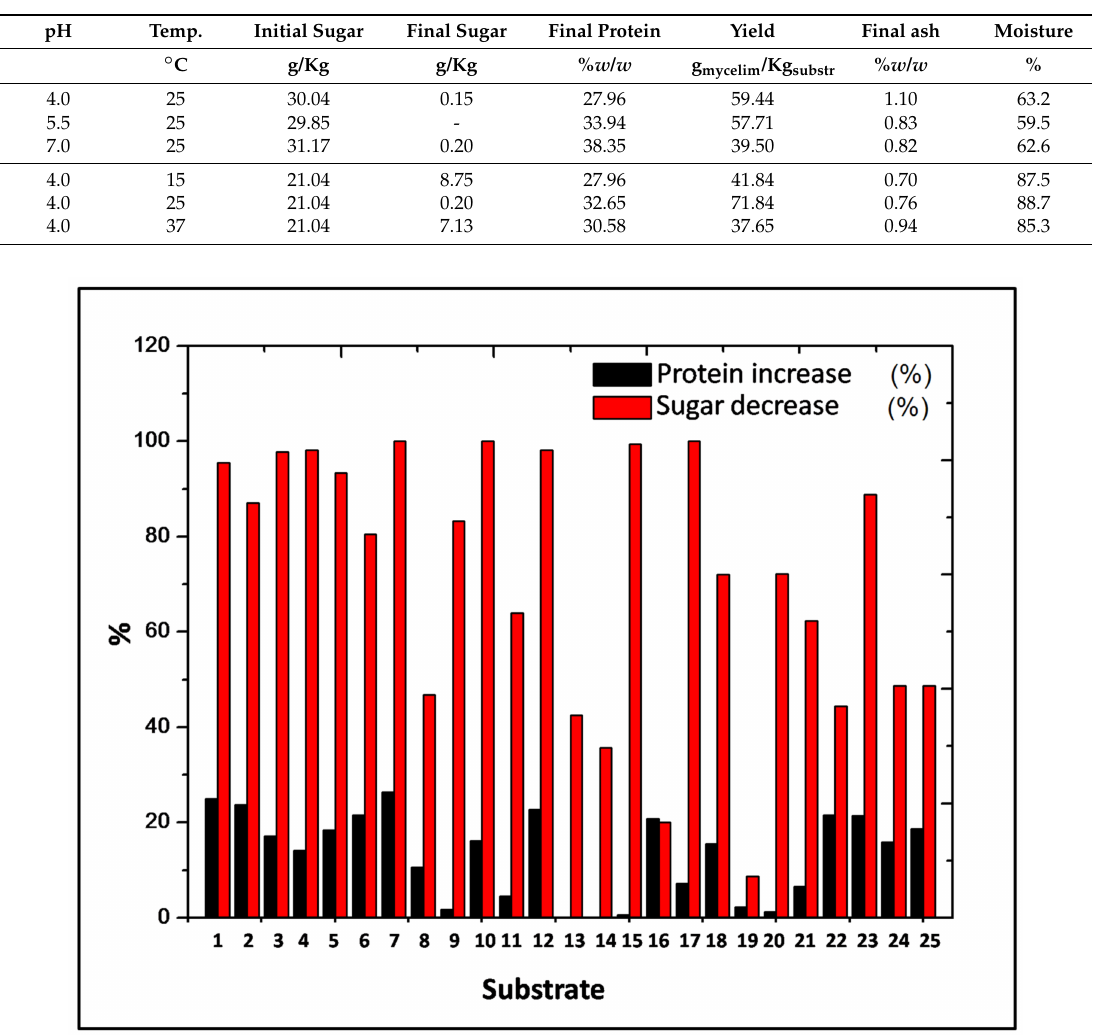
Figure 1. Sugar consumption and protein increase during P. ostreatus growth in the 25 mixed AISS